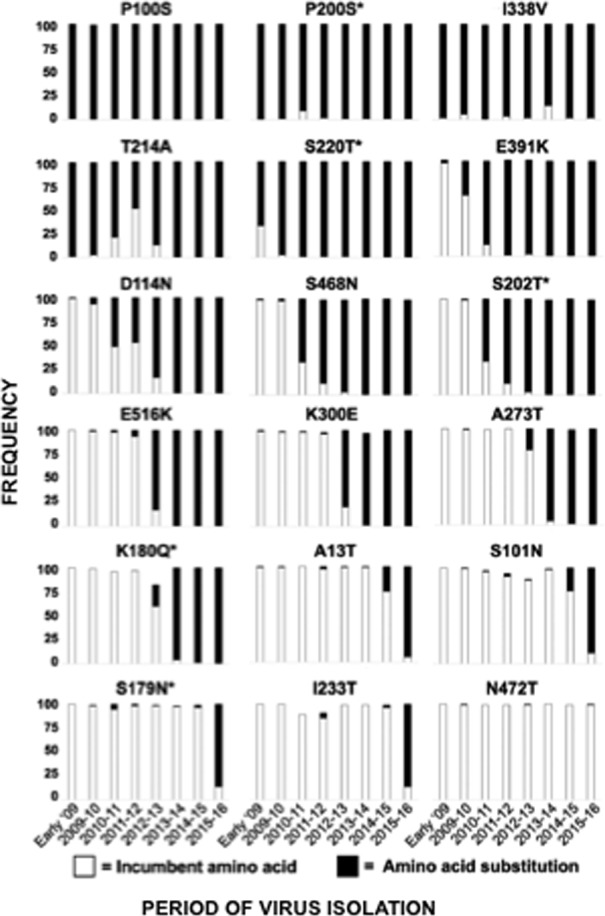
Frequency of HA amino acid changes found in pH1N1-like viruses over time.Publicly available sequences of the HA protein of pH1N1-like strains isolated since 2009 (n = 16,990) were analyzed, and were plotted according to the percentage of sequences containing the original (incumbent) amino acid present in the H1N1 vaccine strain (white) or the substitute amino acid (black) in pH1N1-like isolates at positions 100, 200, 338, 214, 220, 391, 114, 468, 202, 516, 300, 273, 180, 13, 101, 179, 233, 472 from each season since early 2009. An (*) next to the amino acid location indicates that the position is in a previously described antigenic site.